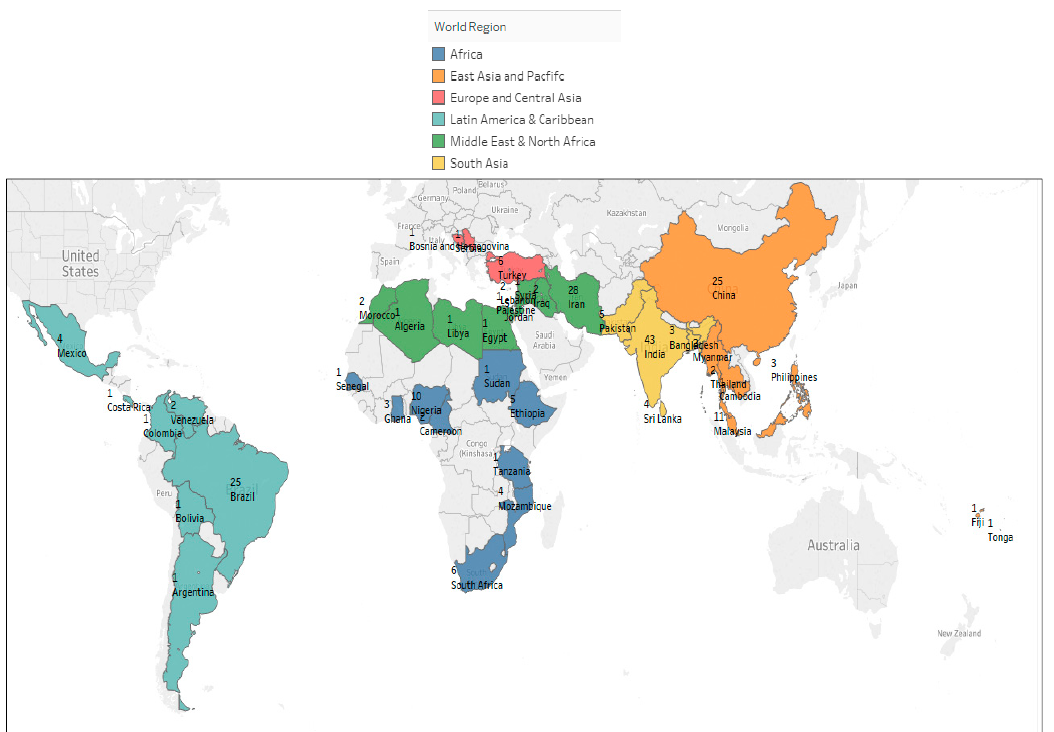
Figure 2. Global map representing records included by region. Table 1. Summarized study characteristics.